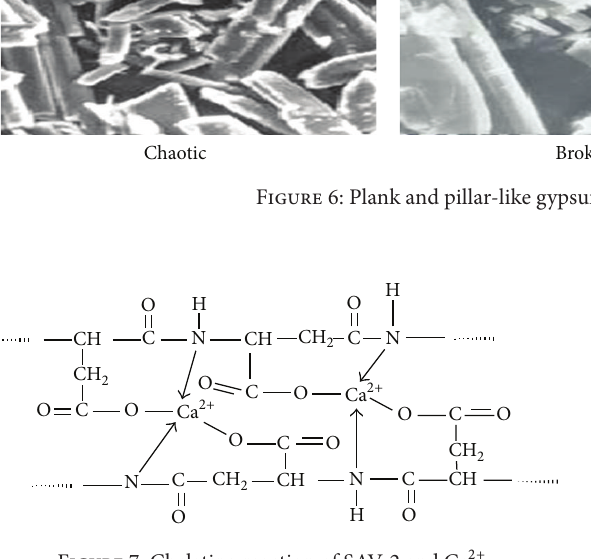
Figure 9: Intercrystalline electrostatic repelling